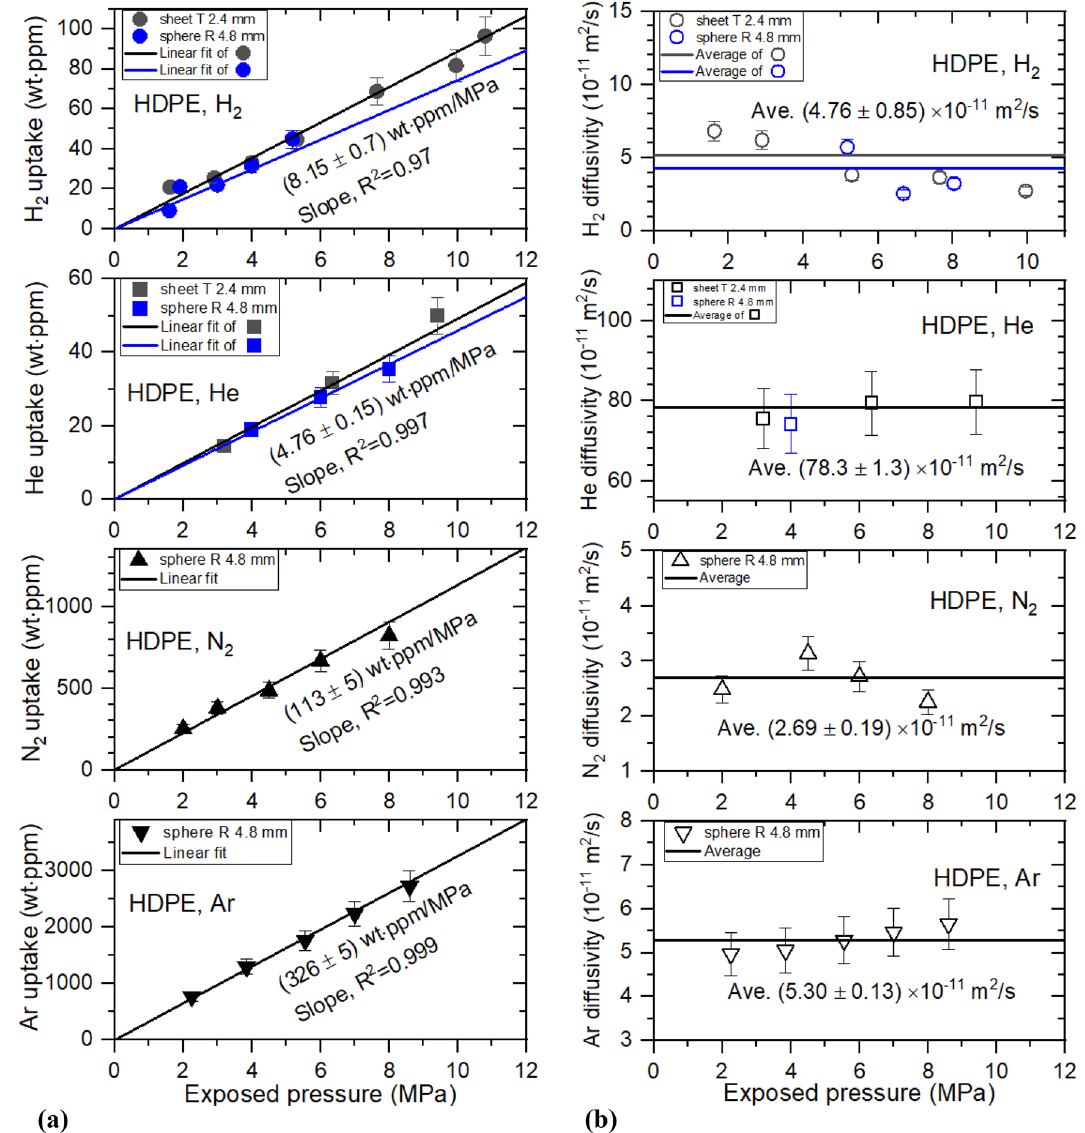
Figure 9. ( a ) Gas uptake ( C ) and ( b ) diffusivity ( D ) versus exposed pressure for four gases in HDPE sheets ∞ with different thicknesses and HDPE spheres. T indicates the thickness of the HDPE sheet. R indicates the radius of the HDPE sphere.